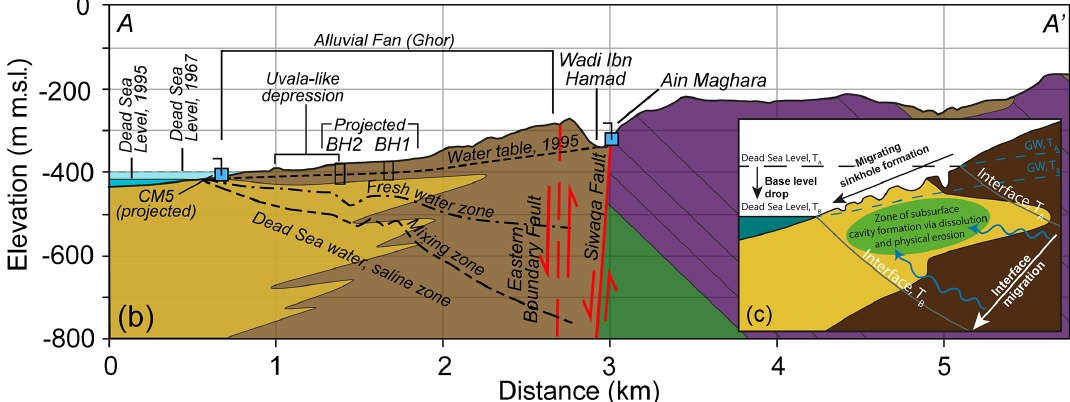
Figure 3. Overview of the hydrogeology of the Ghor Al-Haditha study area. (a) Simplified geological map of the study area, partly based on 1 : 50000 scale mapping of the Jordanian Ministry of Energy and Mineral Resources (Khalil, 1992), mapping and reports (IOH and APC, 1995) and partly our own work. The stratigraphy generally dips acutely to the south-east while striking to the north-east. Also shown is the right-lateral oblique Siwaqa fault, the inferred position of the Eastern Boundary Fault (downthrowing to the west), and the axis of the Haditha syncline. The present locations of the groundwater spring rising in the Wadi Sir limestones of the Ajlun group, “Ain Maghara” and the spring rising at the contact between alluvium and mudflat deposits at the head of channel CM5 are also shown along with the location of the large uvala-like depression described in Al-Halbouni et al. (2017) and Watson et al. (2019). A 2D cross section of geology along the line A–A‘ is shown in (b) . The red and black star indicates the position of the Numeira mud factory, which has been defunct since 2009 after being destroyed by sinkhole formation at the site. (b) Cross section of vertical exaggeration x5 depicting the subsurface hydrogeology as reported for the early months of 1995 (El-Isa et al., 1995) based on borehole information, refraction seismic surveys and VES surveys. The projected depth to the Ram-Kurnub sandstones is based on borehole data (IOH and APC, 1995). (c) Inset depicting the hypothesized conceptual model of seaward migration of sinkhole populations at the Dead Sea as the fresh–saline interface migrates with the base-level drop (Salameh and El-Naser, 2000; Yechieli, 2000; Abelson et al., 2003, 2017; Watson et al., 2019). “GW” here refers to the inferred level of the groundwater in the subsurface; squiggly arrows show the movement of water in the